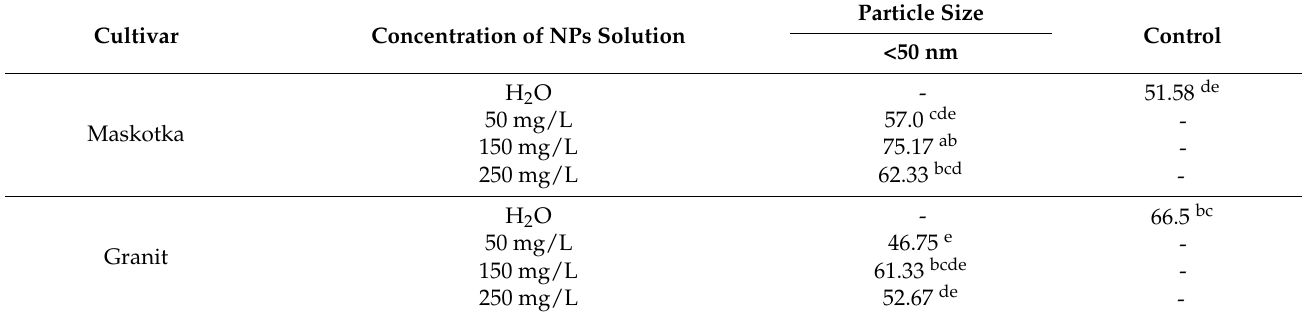
Table A3. The results of germination rate index (GRI) parameter obtained after treatment of <50 nm NPs and statistic calculations. In this table, two variables were taken under consideration (NPs suspension and cultivar type). In statistical part of the table, the statistical significance is expressed as “-”, which means that p -value was higher than 0.05 and certain parameters had no significant influence on the results; “**” means that p -value is lower than 0.01, and “***” means that p -value is lower than 0.001. Small letters indicate the significant differences for p -value ≤